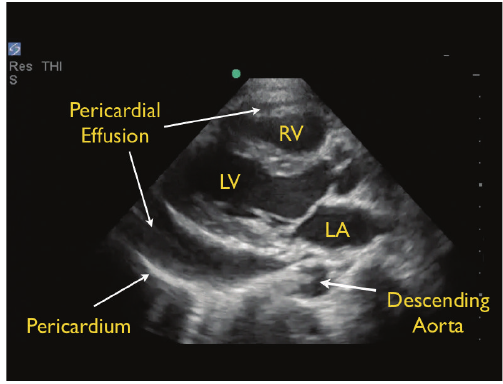
Figure 3: Pericardial e ff usion, parasternal long axis view. RV: right ventricle, LV: left ventricle, LA: left atrium.